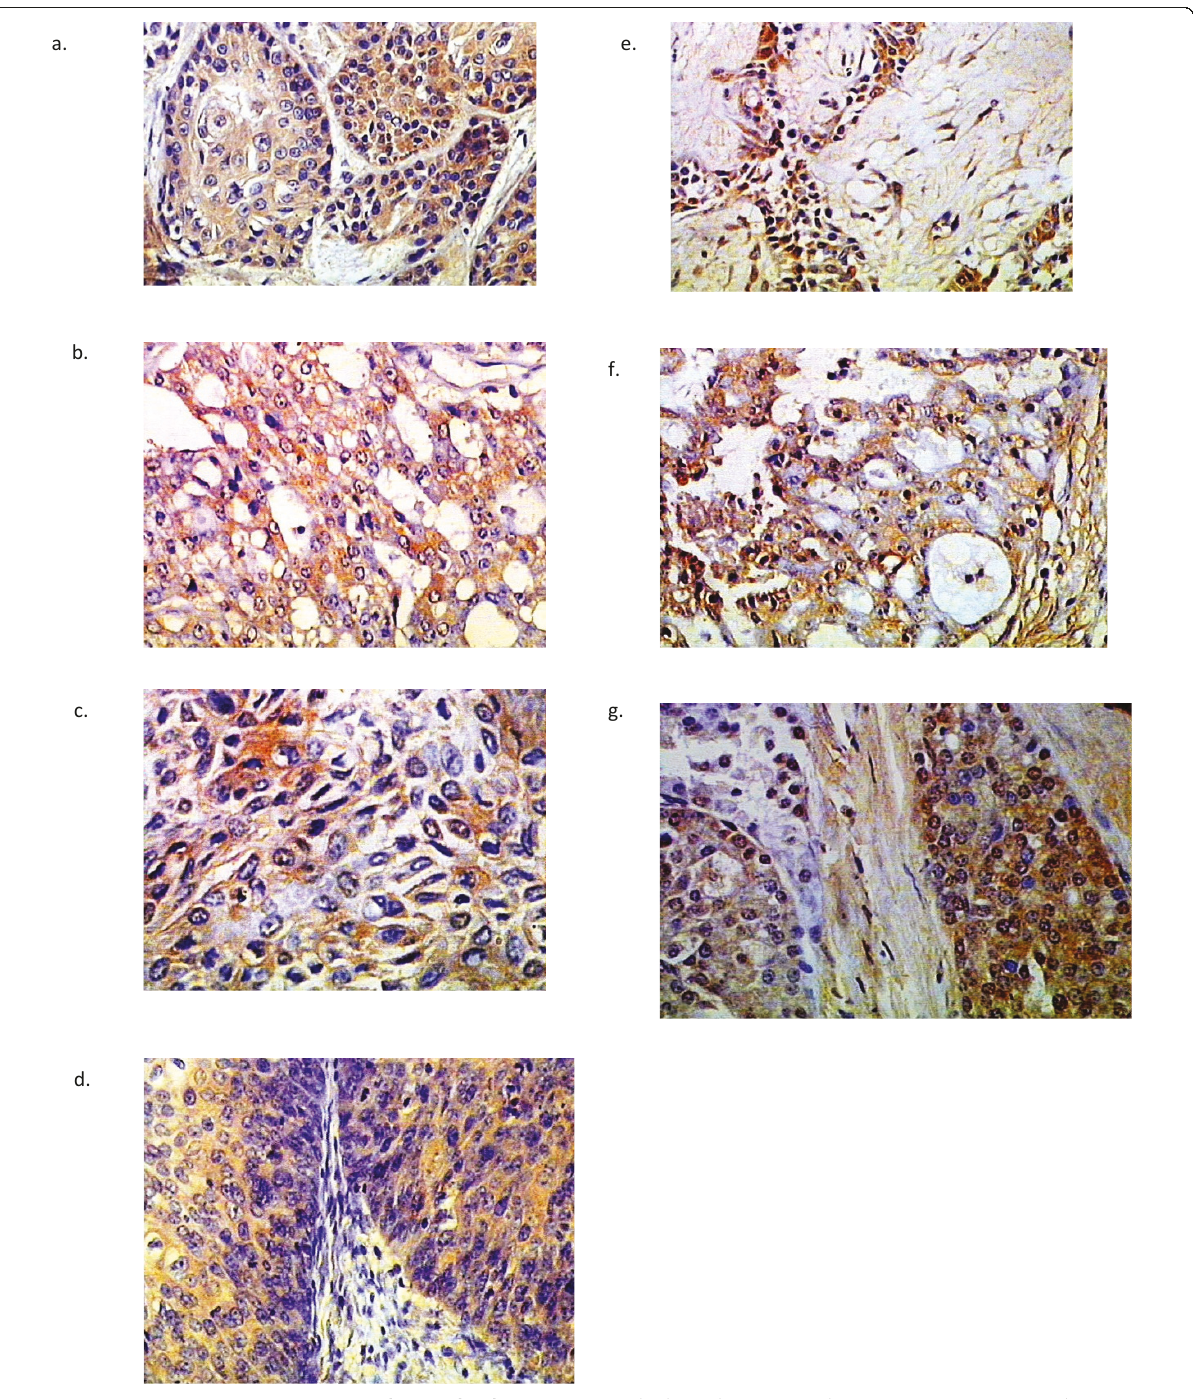
Figure 2 MCM2 expression patterns in salivary gland carcinomas . a: high grade MECx200. b: ADCCx200. c: EMCx400. d: SDCx200. e: MPAx200. f: PLGAx200. g: